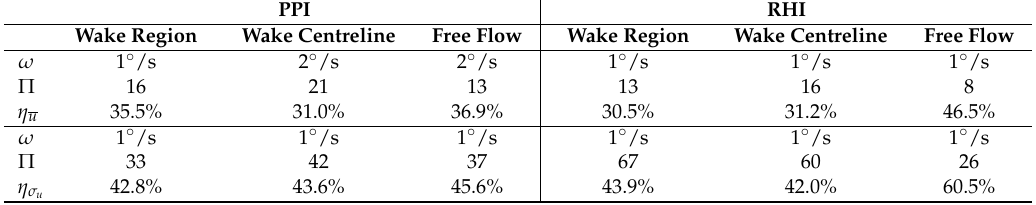
for different cases of PPI and RHI data. u